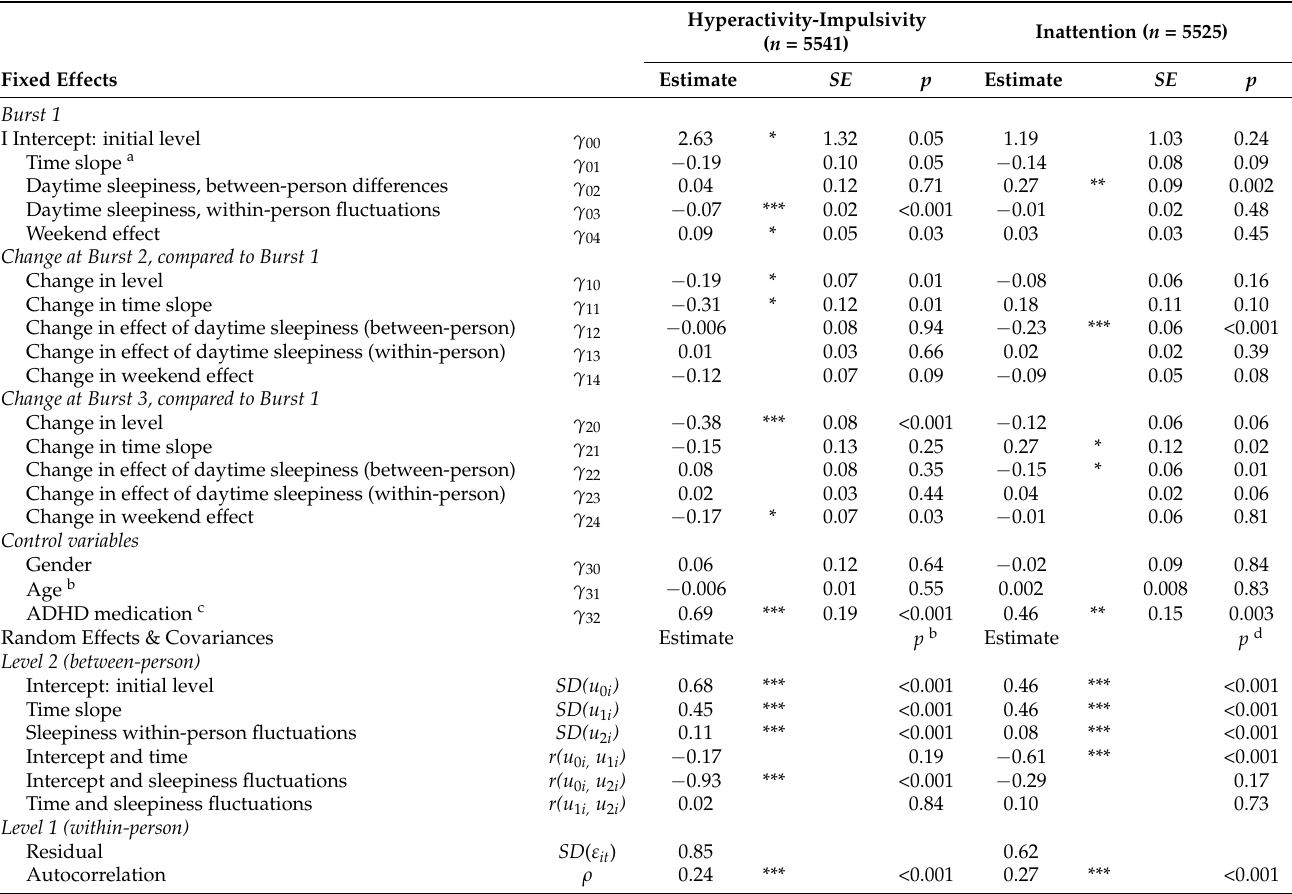
Table A2. Multilevel model to test the between- and within-person association between children’s daytime sleepiness and concurrent ADHD symptom levels, separately for symptoms of hyperactivity- impulsivity and